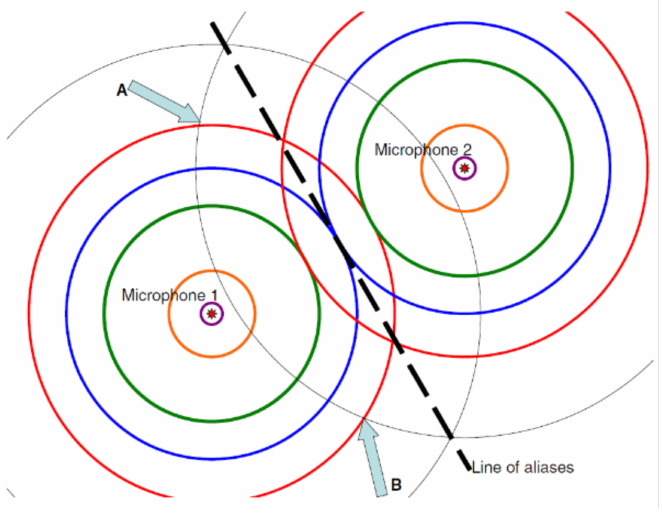
Figure 6. A two microphone configuration